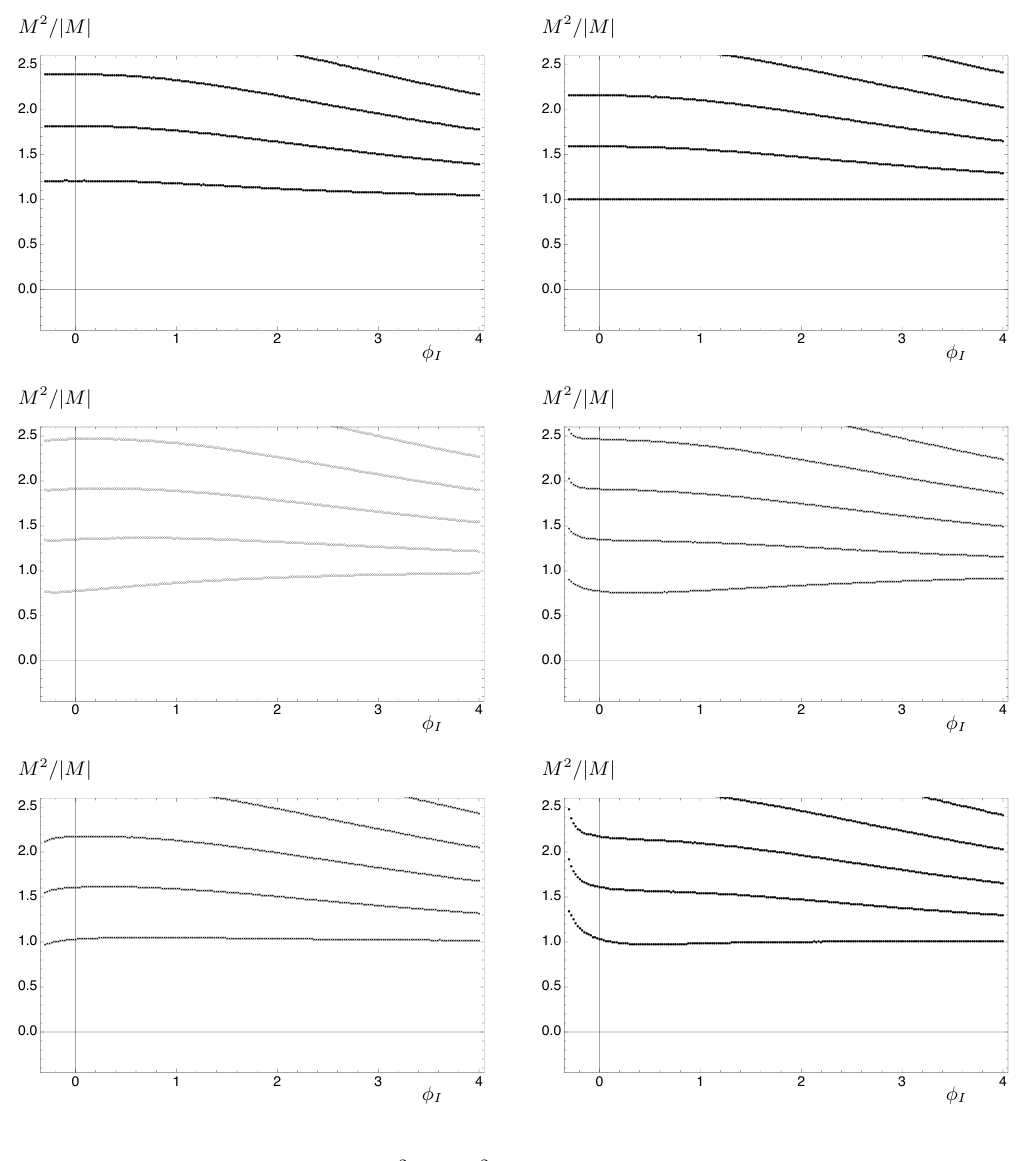
Figure 5 . Mass spectrum, with M 2 = − q 2 , of the (gauge-invariant) transverse fluctuations of the 1 -forms, as a function of the parameter φ . The masses are normalised to the lightest tensor I mode. The markers are chosen to match the representations under SO(4) . Left to right and top to bottom: χ , ω , the six A ¯ A (all these states are also called vectors elsewhere), the four A ˆ A µ µ µ four S , and S (the axial-vectors). Numerical calculations use ρ 67 µ 5 67 µ ¯ β